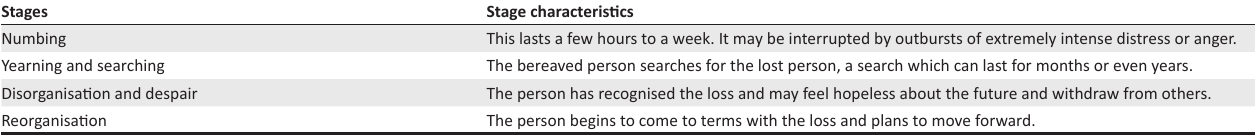
TABLE 1: Bowlby’s four stages of grief their